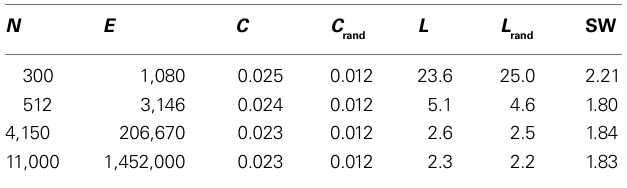
Table 1 | Graph and small-world characteristics of hierarchical networks with constant edge density.